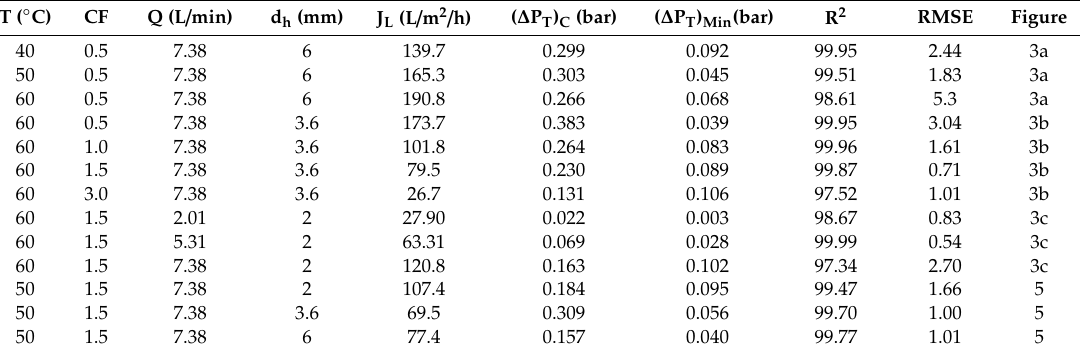
Table 3. Model prediction and parameters determination (average